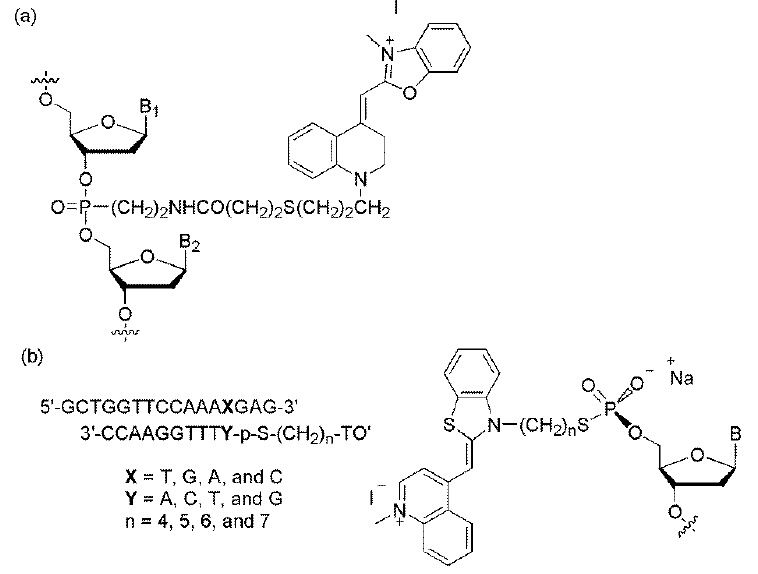
Figure 3. ( a ) YO -linked probe and ( b ) TO -linked probe.